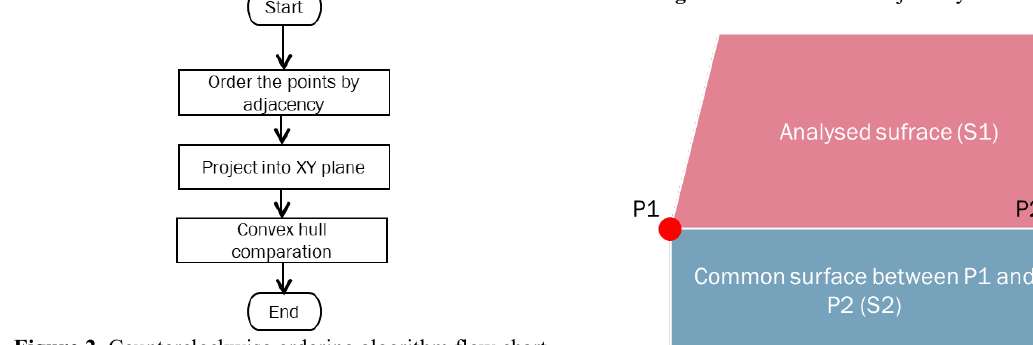
Figure 3. Flow chart of adjacency ordering of vertexes.